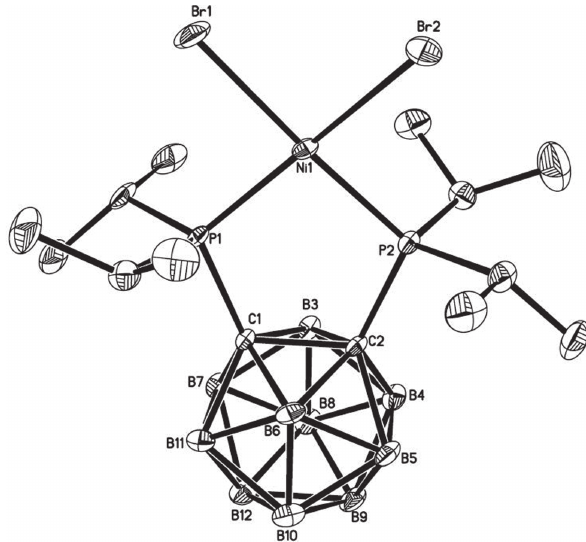
Table 1: Data collection and